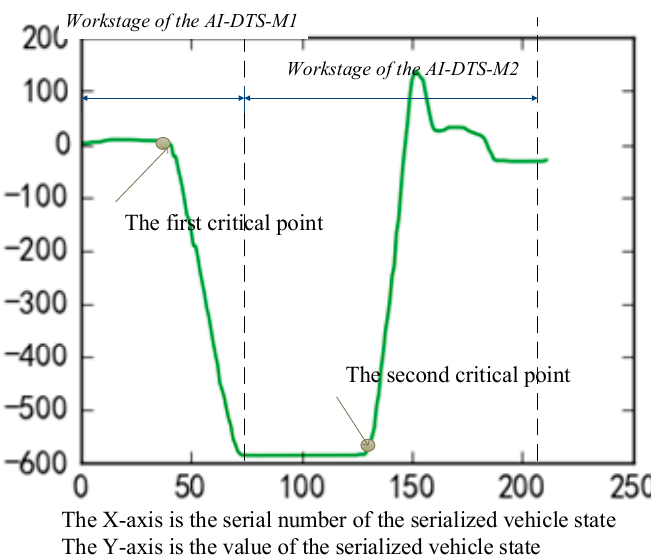
Figure 16. Work stage division of the AI-DTS-M1 and the AI-DTS-M2.